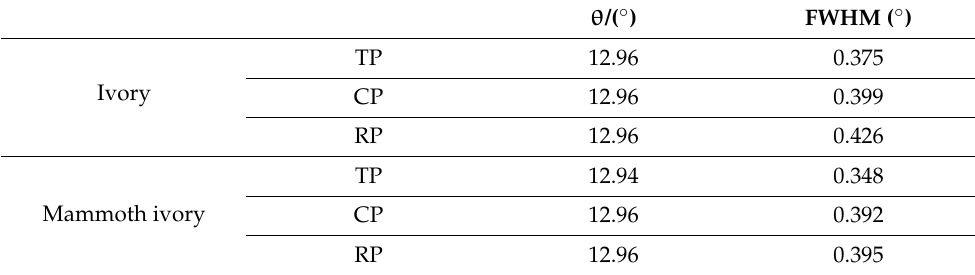
Table 1. Full width at half maximum of the (002) peak of different